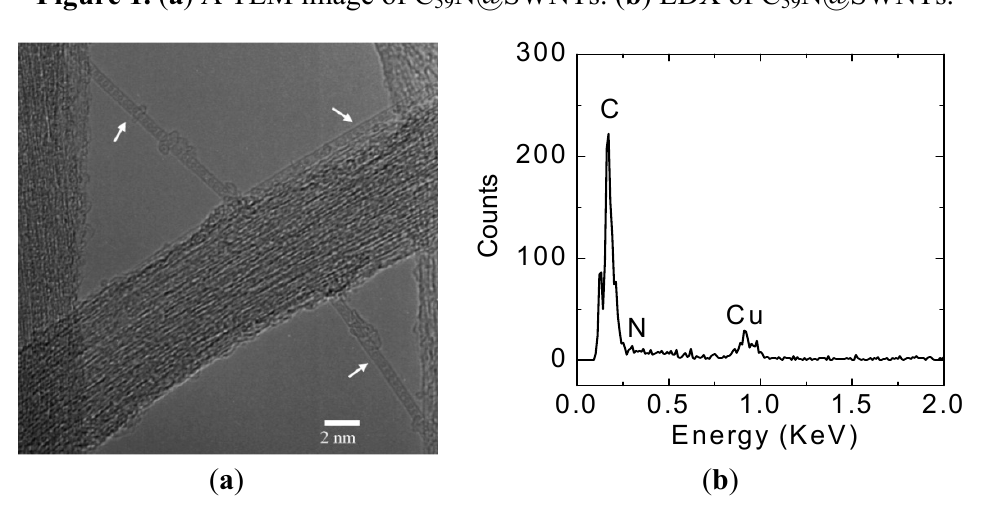
Figure 2. ( a ) Schematic illustration of FET configuration with a SWNT as current